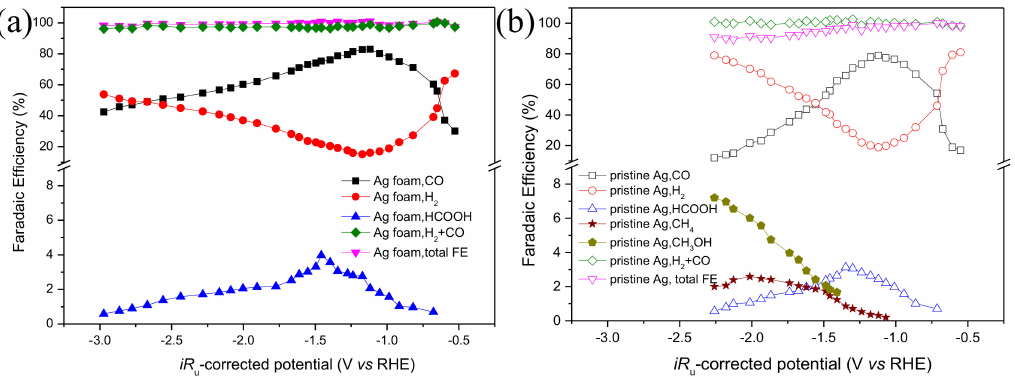
Figure 5. Faradic efficiency of the CO 2 reduction products for Ag foam ( a ) and pristine Ag ( b ) electrodes as a function of electrode potential during the electrolysis process. Experimental conditions: anolyte, 0.5 M NaOH; catholyte, CO 2 -saturated 0.1 M KHCO 3 ; 25 ◦